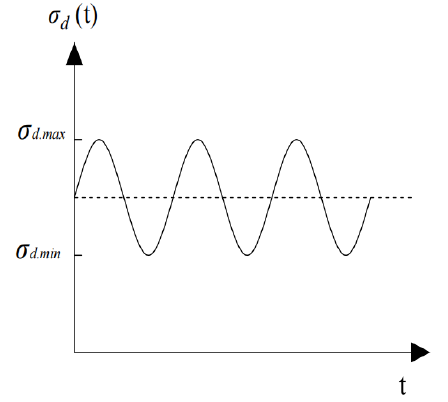
Figure 1. Diagrammatic sketch of cyclic stress.